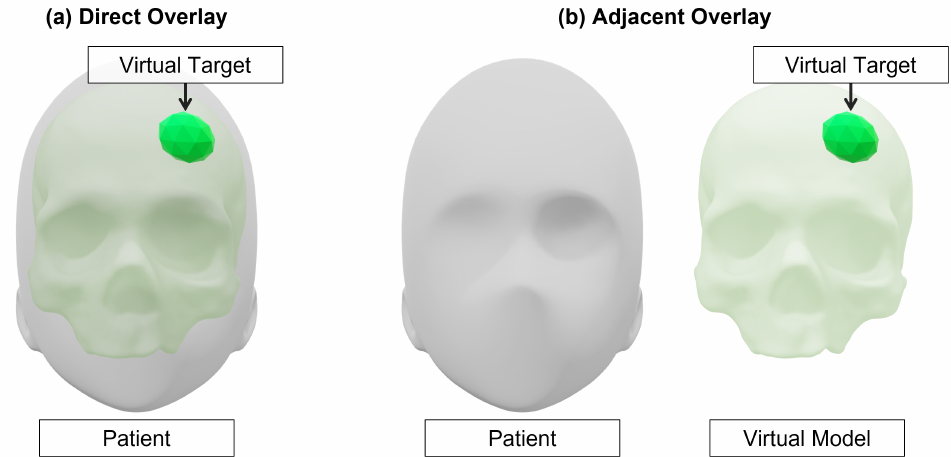
Figure 10. Demonstration of the difference between direct overlay of virtual content and adjacent overlay of virtual content. Direct overlay will include virtual content which is directly superimposed with the patient anatomy ( a ). Adjacent overlay involves the placement of virtual content next to the patient to improve data accessibility ( b